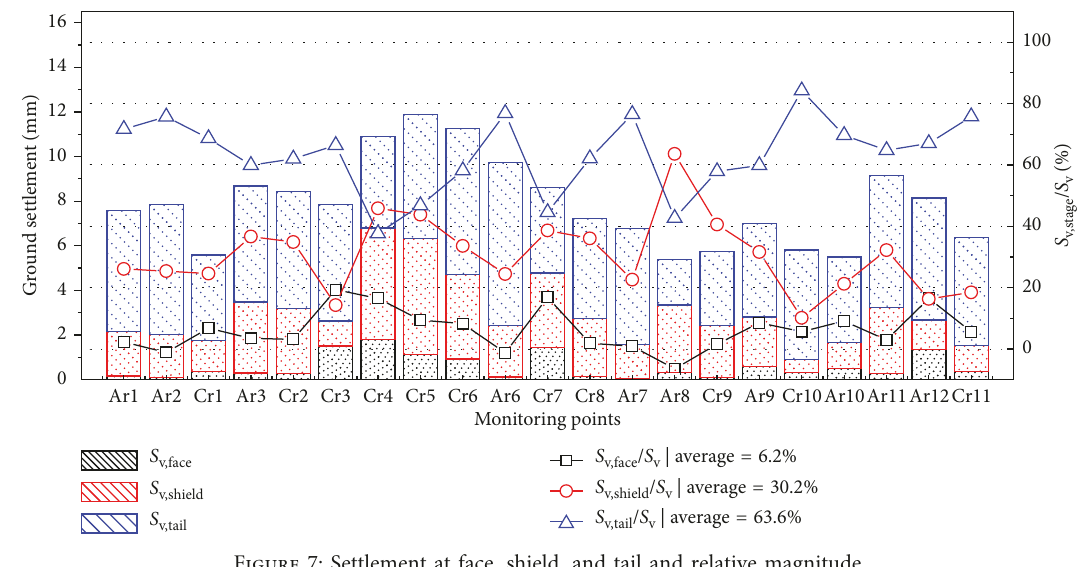
Figure 7: Settlement at face, shield, and tail and relative